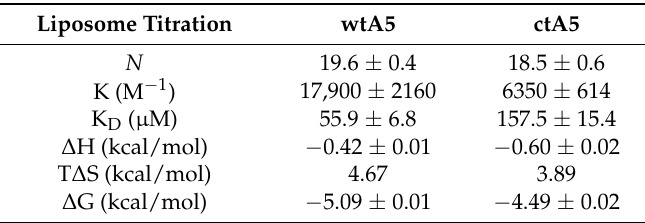
Figure 6. Titration of wtA5 and ctA5 with liposome in the absence of calcium. The data was processed and has been presented in the same way as indicated in Figure 5. Table 2. Parametric analysis of liposome titration. Liposome Titration